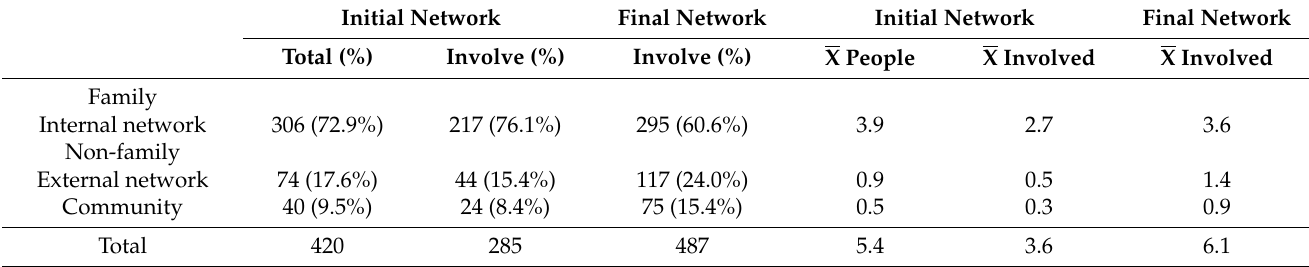
Table 2. People in the initial and final support